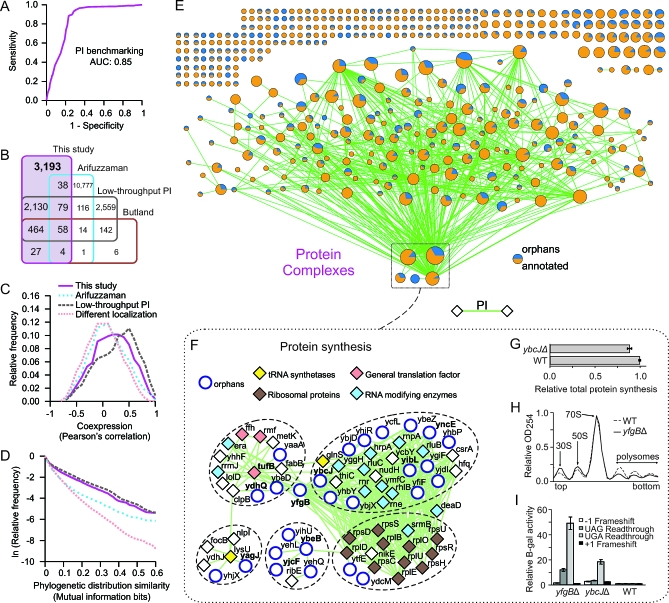
High-Confidence Physical Interactions and Putative Multiprotein Complexes(A) Benchmarking of the experimentally derived PI network in E. coli against positive and negative gold standards by receiver operating characteristic (ROC)-curve analysis; cumulative area-under-the-curve (AUC) is shown as an overall performance measure.(B) Overlap of PI identified in this study with previous proteomic reports [1,4] and low-throughput PI obtained from DIP, BIND, and IntAct.(C and D) Putatively interacting proteins have highly correlated gene expression patterns (C) and similar phylogenetic profiles (D) based on mutual information as for low-throughput curated PI and in contrast to control protein pairs derived from different subcellular compartments.(E) Graphical schematic of putative stable, soluble multiprotein complexes, drawn using the GenePRO Cytoscape plugin [104] (see Table S7 for listing). Each node represents a complex, whose size reflects the number of contained proteins; edge widths reflect the number of interactions between subunits of different complexes.(F) Multiprotein complexes implicated in the bacterial translation apparatus; orphan and annotated genes mentioned in the main text are highlighted in bold.(G) Reduced rate of total protein synthesis in a strain lacking ybcJ relative to wild-type cells (WT).(H) Perturbed ribosome profiles in an yfgB deletion strain.(I) Elevated rates of frame-shifting and stop-codon readthrough in yfgB and ybcJ deletion strains relative to wild-type (WT). β-gal activity is only produced after the corresponding translational defect has occurred; error bars indicate standard deviation.